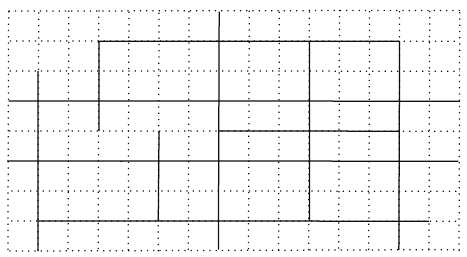
Figure 2: Example of an actual road network in an analytic